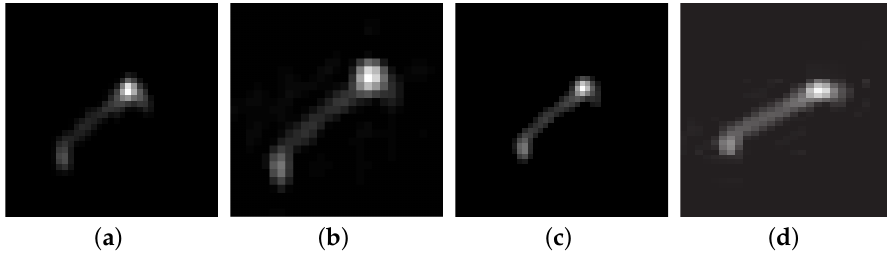
Figure 9. Comparison of blur kernel estimation: ( a ) blurred image; ( b ) Shan_2008. ( c ) Krishnan_2011; ( d ) Jia_2013; and ( e ) our proposed